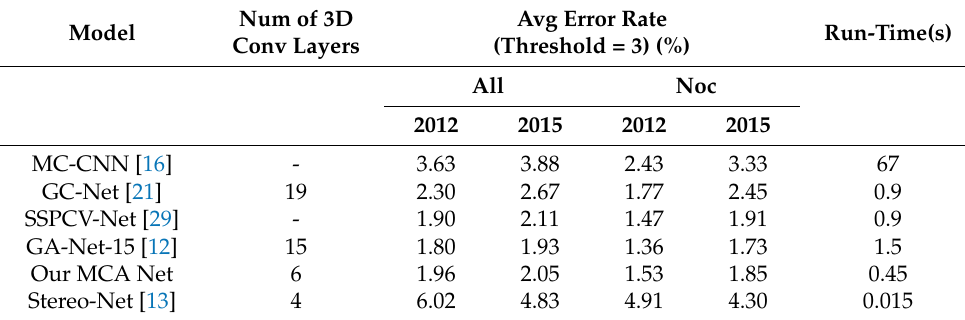
Table 4. Test results on KITTI2012 and KITTI 2015.